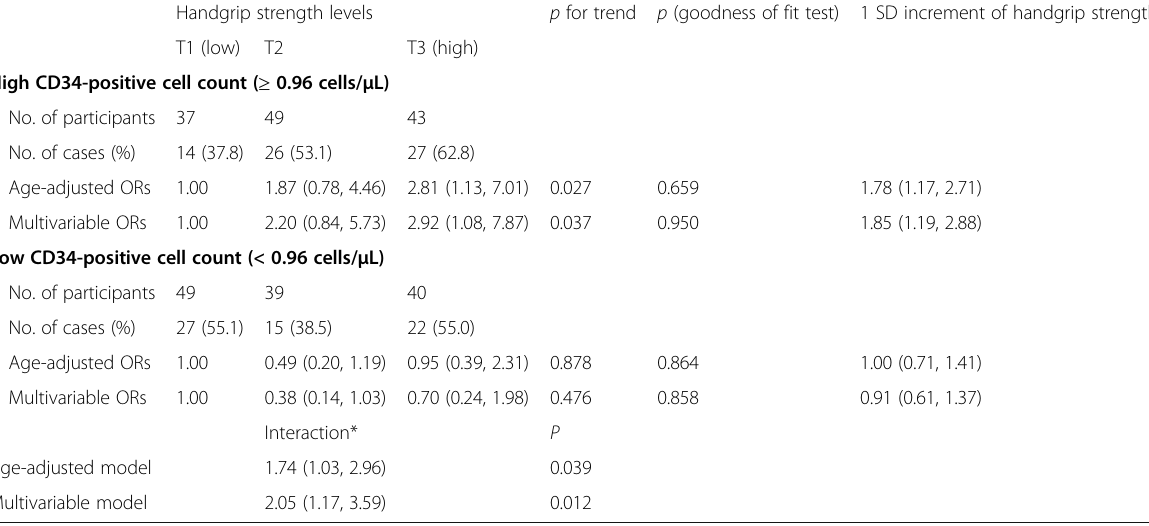
Table 2 Odds ratios (ORs) and 95% confidence intervals (CIs) for hypertension in relation to handgrip strength stratified by circulating CD34-positive cell count Handgrip strength levels